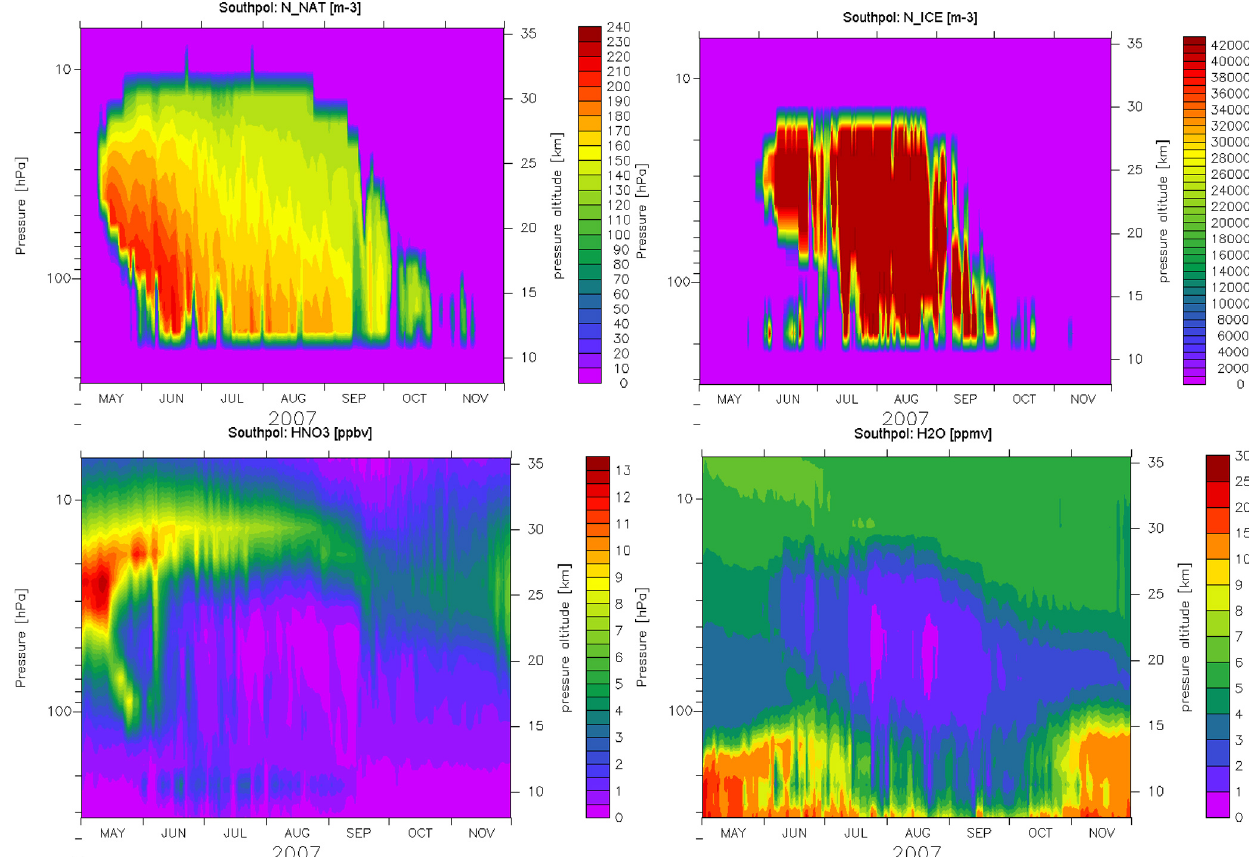
Fig. 1. Time series from May 2007 to November 2007 (zonally averaged polewards of 87.9 ◦ S): Number density of NAT particles ( N NAT in particlesm − 3 , top left), number density of ice particles ( N ice in particlesm − 3 , top right), mixing ratio of HNO 3 (in nmolmol − 1 , bottom left) and mixing ratio of H 2 O (in µmolmol − 1 , bottom